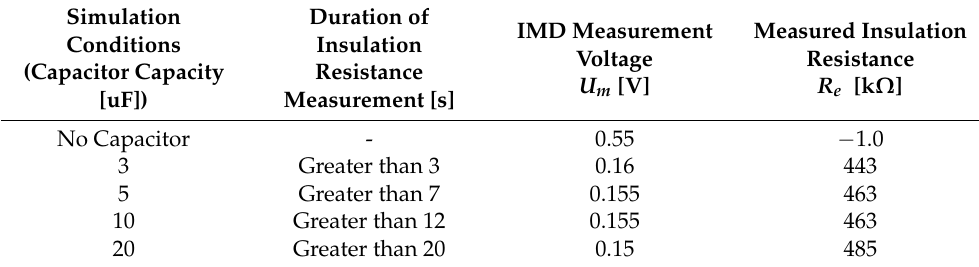
Table 2. Simulation result of IMD (according to capacitor capacity).